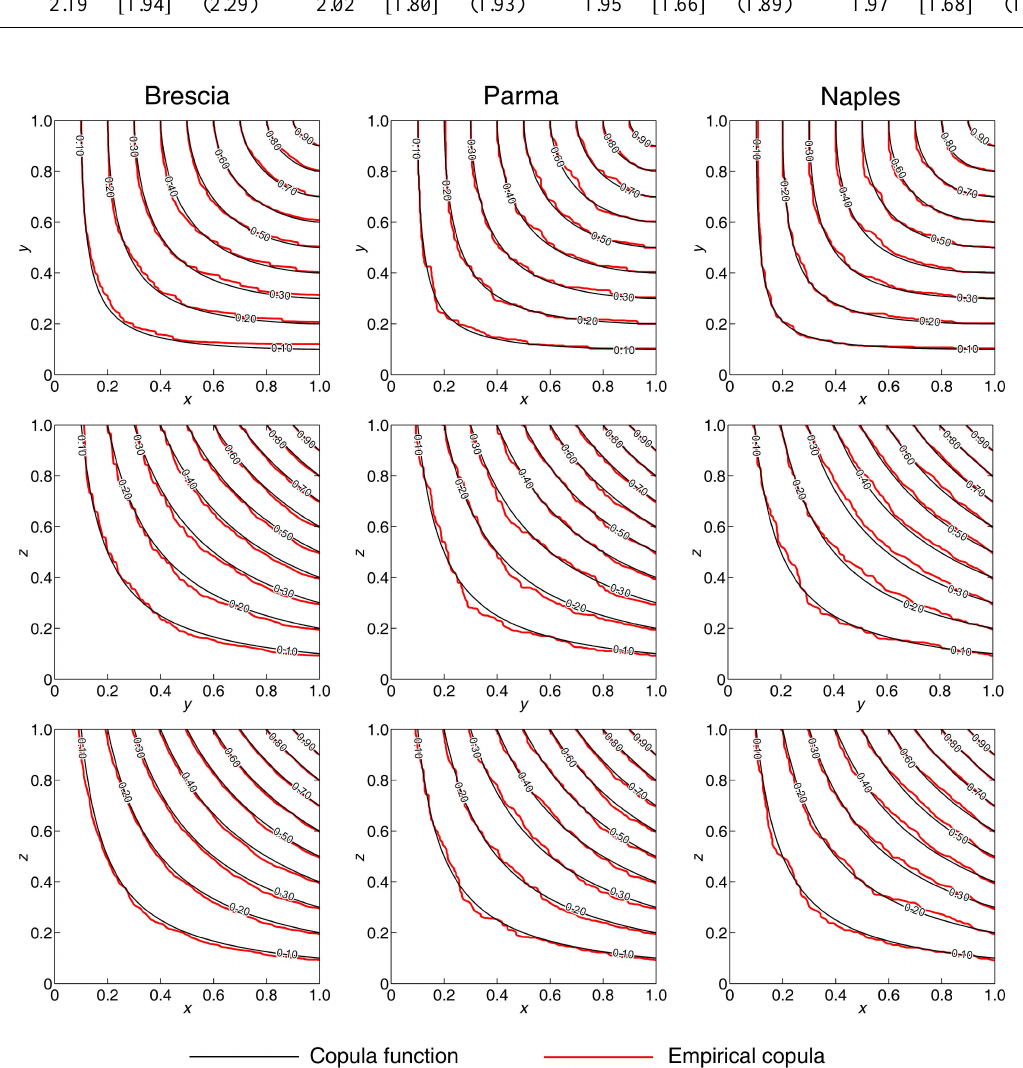
Fig. 3. Contour lines of fitted copula functions and empirical copulas for samples extracted by using IETD=12h and